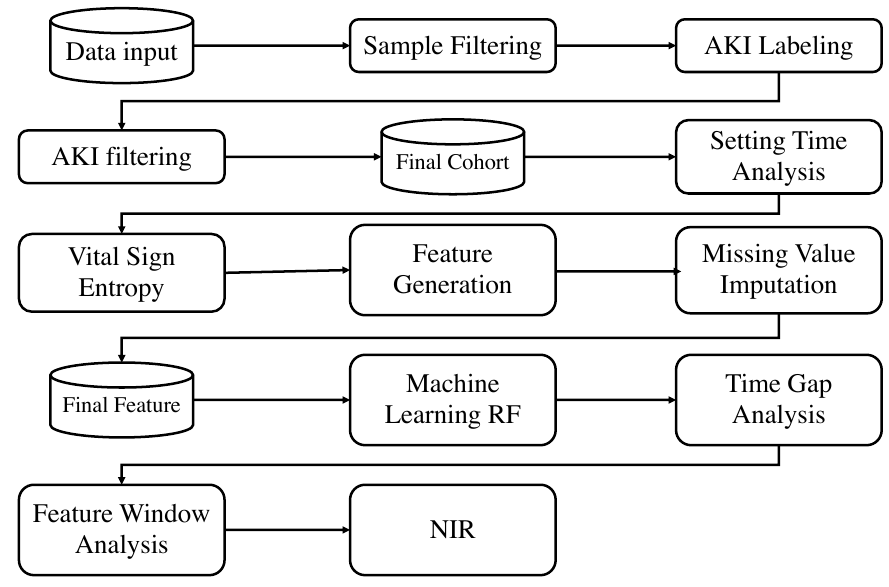
Figure 3. Overall